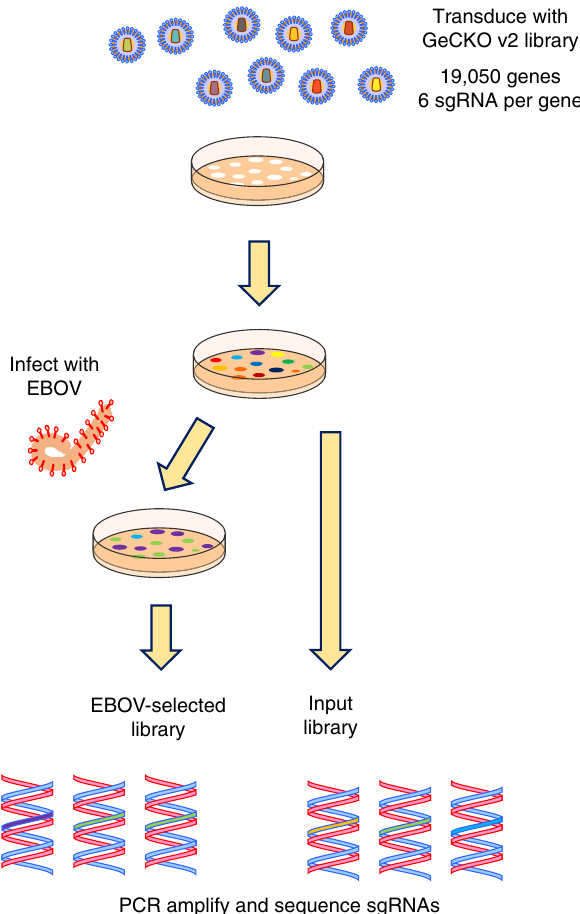
Fig. 1 A CRISPR screen to select for knockout cells resistant to EBOV infection. The GeCKO v2 lentiviral CRISPR library was used to transduce Huh7.5.1 cells. The selected cells were infected with authentic EBOV and surviving cell colonies expanded. The sgRNAs were ampli fi ed and sequenced, and compared to those from the original transduced